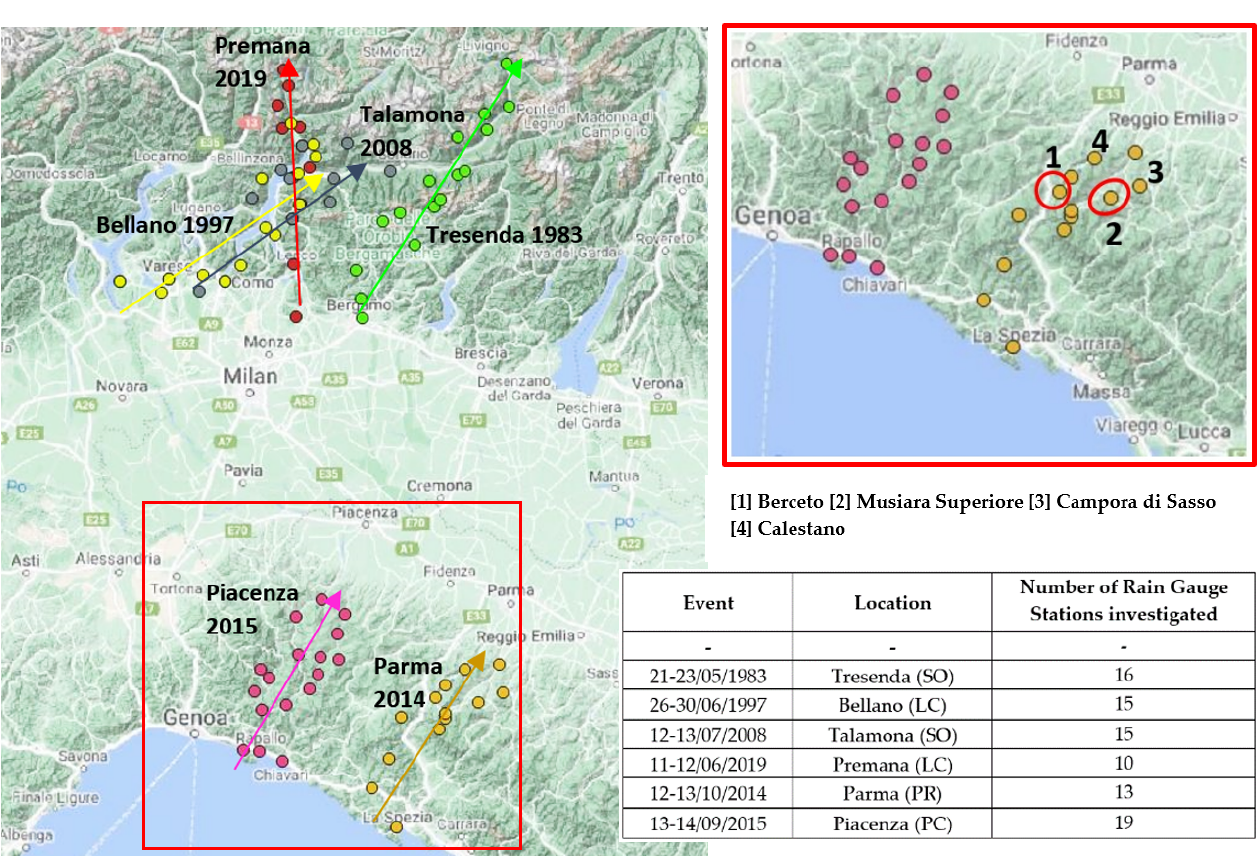
Table 2. Studied events of extreme precipitation. Dates, locations, and extreme precipitation param- eters that describe the maximum amount, the duration, and the return period, and the hydrogeo- logical effects recorded on the territory. For 2008, 2014, and 2015 events, (**) represents the duration of the most intense phase, while () is the duration of the entire event.